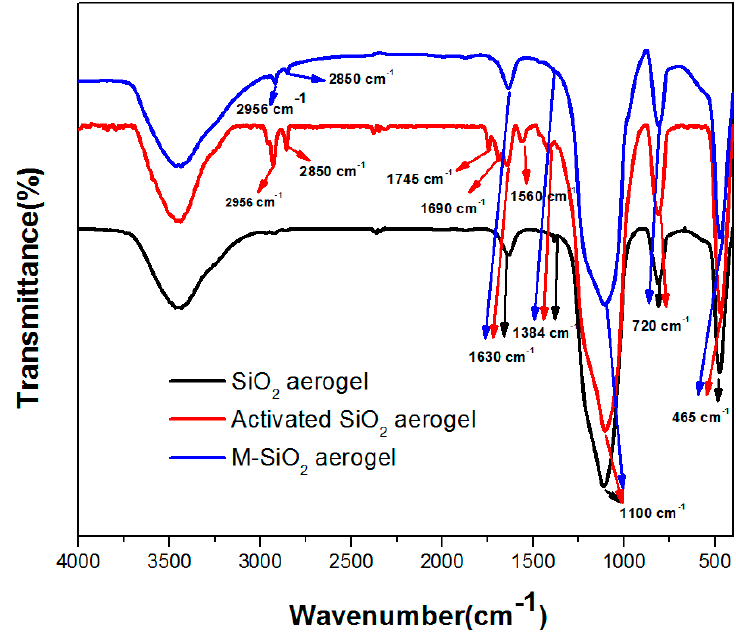
Figure 2. The FT-IR spectrum of SiO 2 , activated SiO 2 , and M-SiO 2 aerogels.